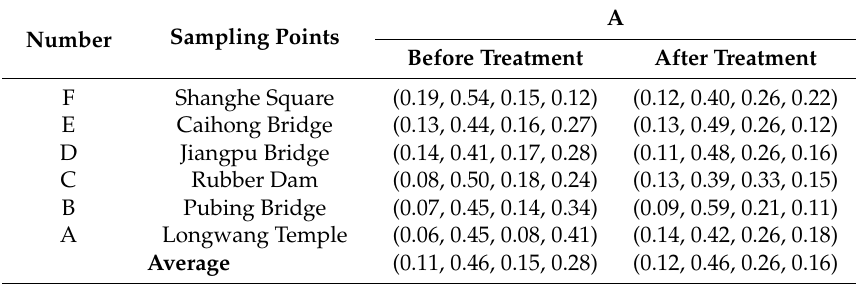
Table 10. The weight coefficient fuzzy subset A of the six monitoring